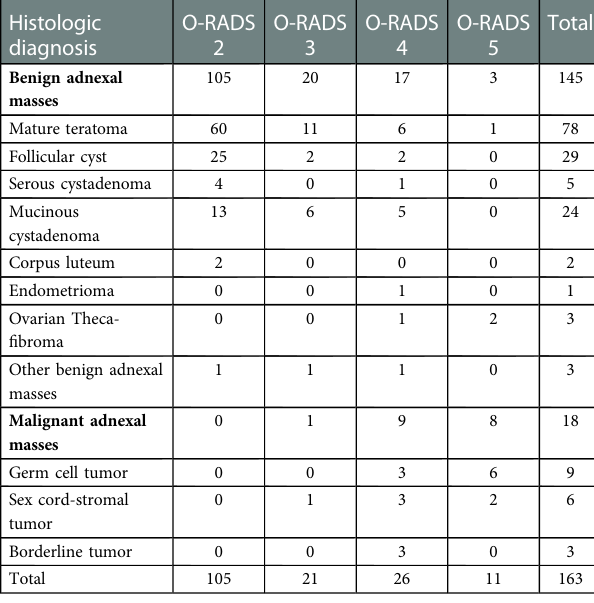
predictive value of O-RADS 4 and 5 categorization for malignant lesions were 94.4%, 86.2%, 86.2%, 45.9%, and 99.2%, respectively. The O-RADS 4 lesions include the following: (1) unilocular cyst with solid component; (2) multilocular cyst, no solid elements; (3) multilocular cyst with solid component; (4) solid or solid appearing. If unilocular cyst with solid component and multilocular cyst with no solid elements are categorized as O-RADS 4A masses and the remaining cystic lesions with solid components are categorized as O-RADS 4B masses, the malignancy rates were 10.0% and 50.0%, respectively ( Table 4 ),